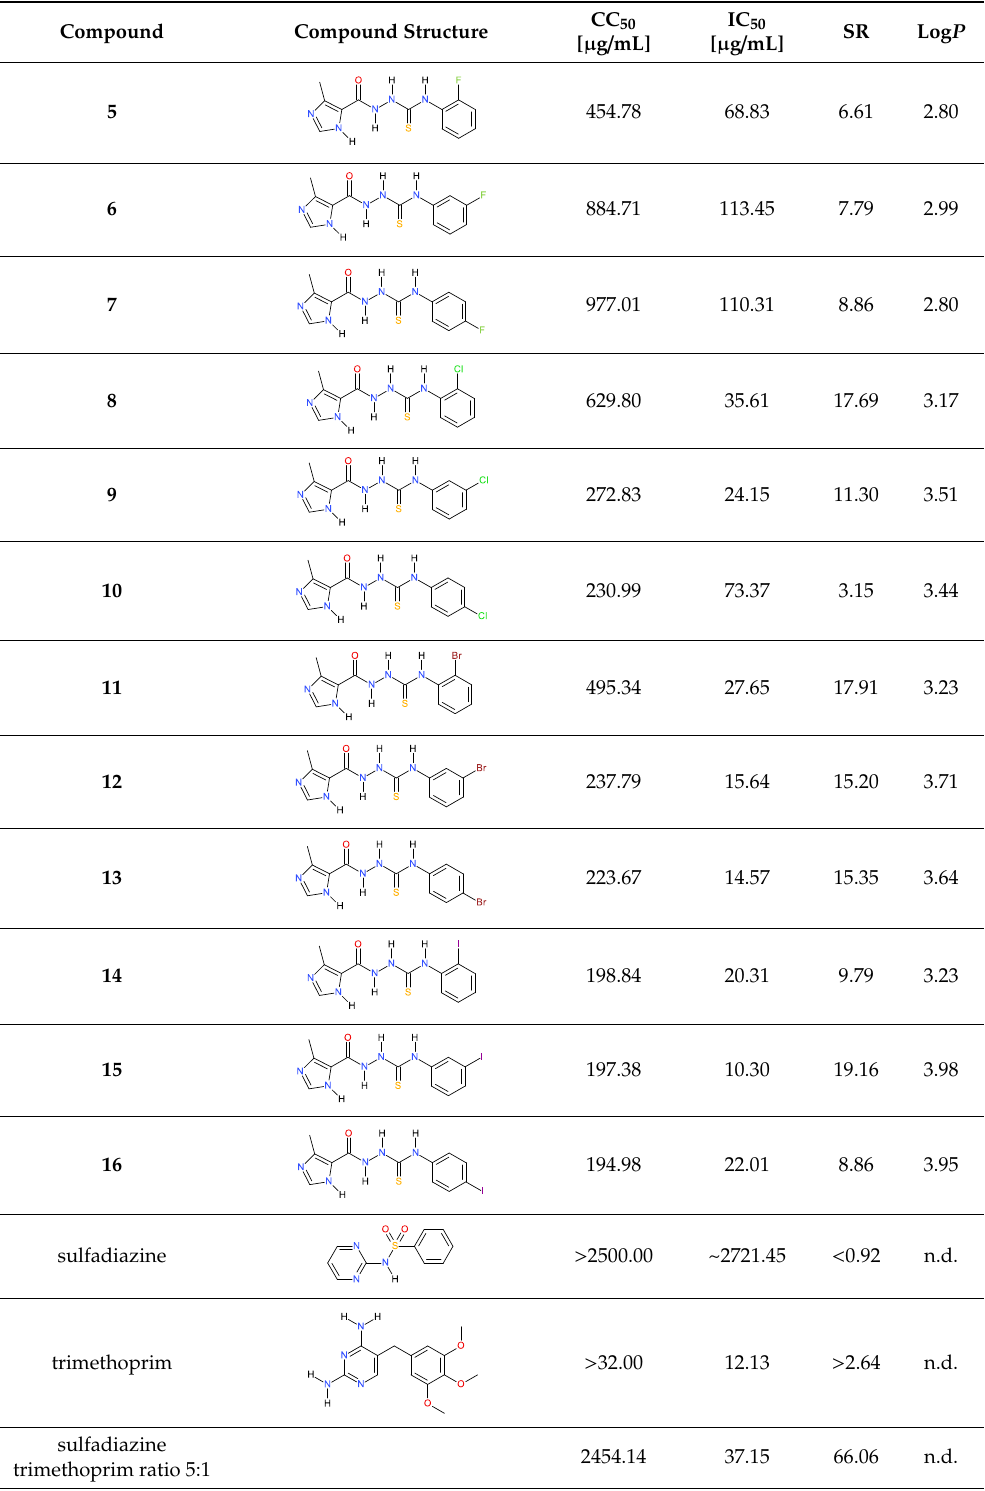
Table 2. The CC 50 , IC 50 , and the selectivity ratio (SR) of the halogenated-substituted imidazole-thiosemicarbazides 5 – 16 .